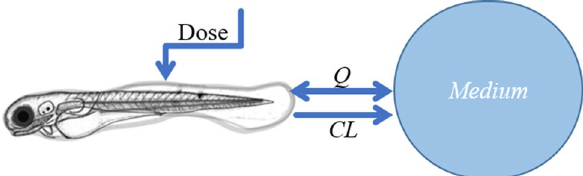
Figure 8. Schematic illustration of the 1-compartment model used to calculate PK parameters of the fluorescent compounds in the zebrafish eleuthero-embryo. One-way active clearance CL (L/h), passive exchange Q (L/h), compound in the medium (mg/L) and dose administrated by microinjection (mg/kg). The image was drawn using MS PowerPoint and GIMP (version 2.10.24 https:// www. gimp. org/ 2021)